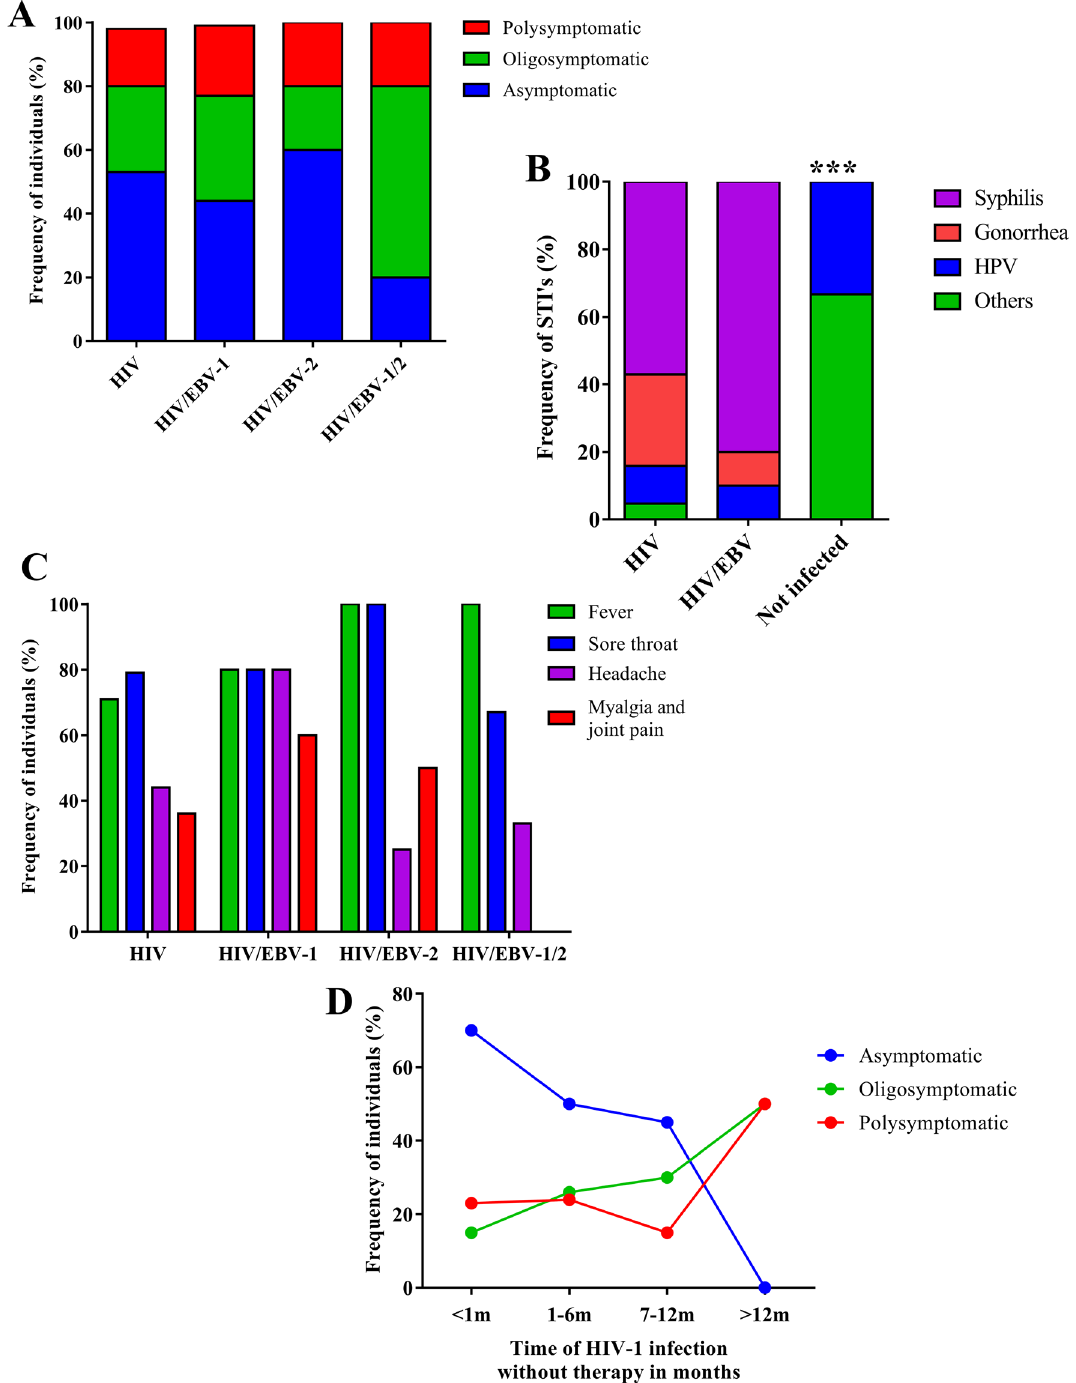
Figure 3. Symptoms: ( A ) Frequency of symptomatological categories among the studied groups. ( B ) STI diversity among individuals with a history of sexually transmitted infections in the studied groups. Blood donors had a poorly diversified history. *** ***: p<0.001. ( C ) Diversity of symptoms between the studied groups. Fever and sore throat were the most frequent. ( D ) Evaluation of the frequency of the symptomatological categories at different initiation times for HIV-1 infection treatment. There was an extreme reduction in the frequency of asymptomatic patients among patients for whom treatment was initiated greater than 12 months after